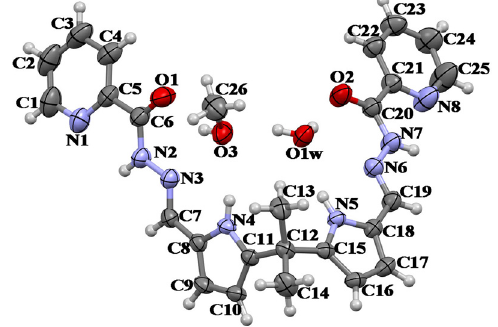
re fl uxed for 12 h, and then the mixture was cooled to room temperature. The yellow precipitated residue was removed from the solution by fi ltration and then washed with ethanol three times. The yellow solids (0.2 mmol) were dissolved in a solution mixture (45 ml, CH 8:1, v/v). Single crystals were obtained by slow evapora- tion at room temperature.